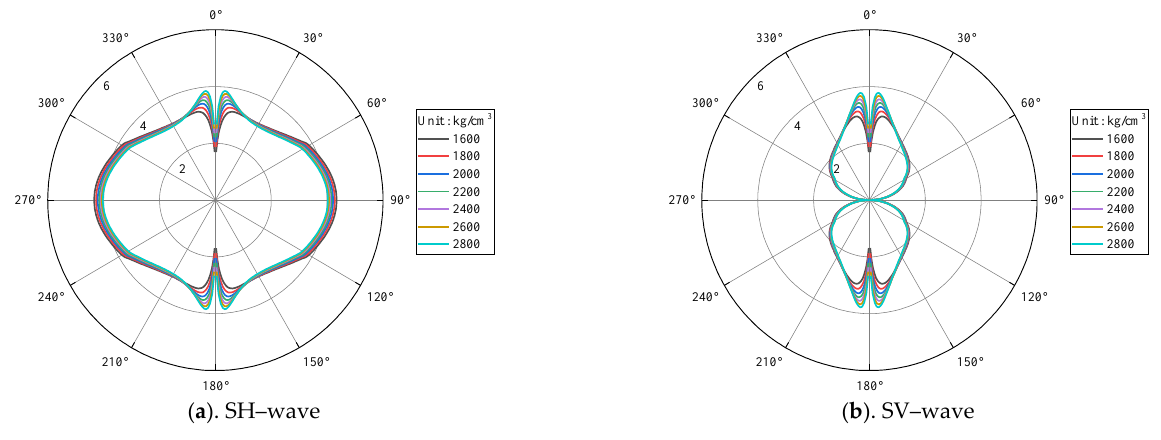
Figure 4. Radiation characteristics of SH – wave and SV – wave of a dipole source under different formation densities.